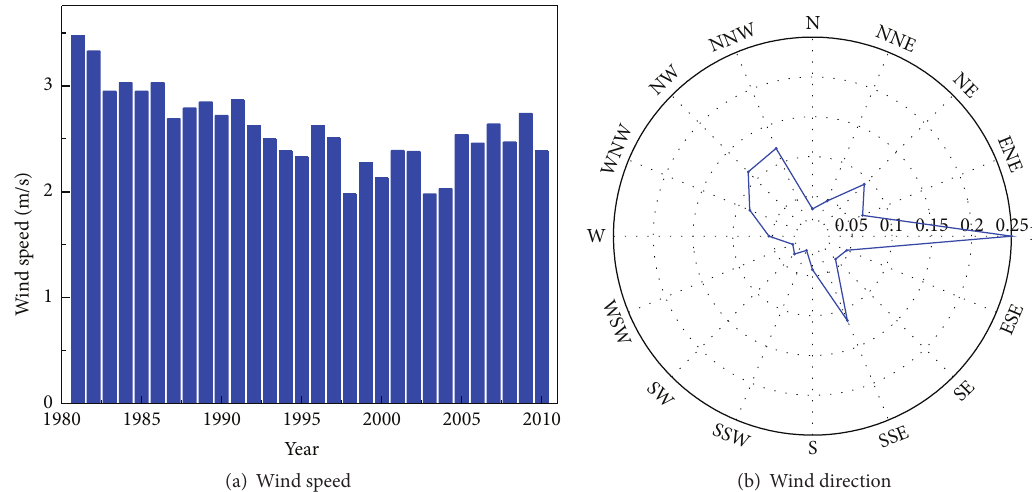
Figure 1: Annual average wind speed and wind direction during 1981–2010 year in Guazhou meteorological